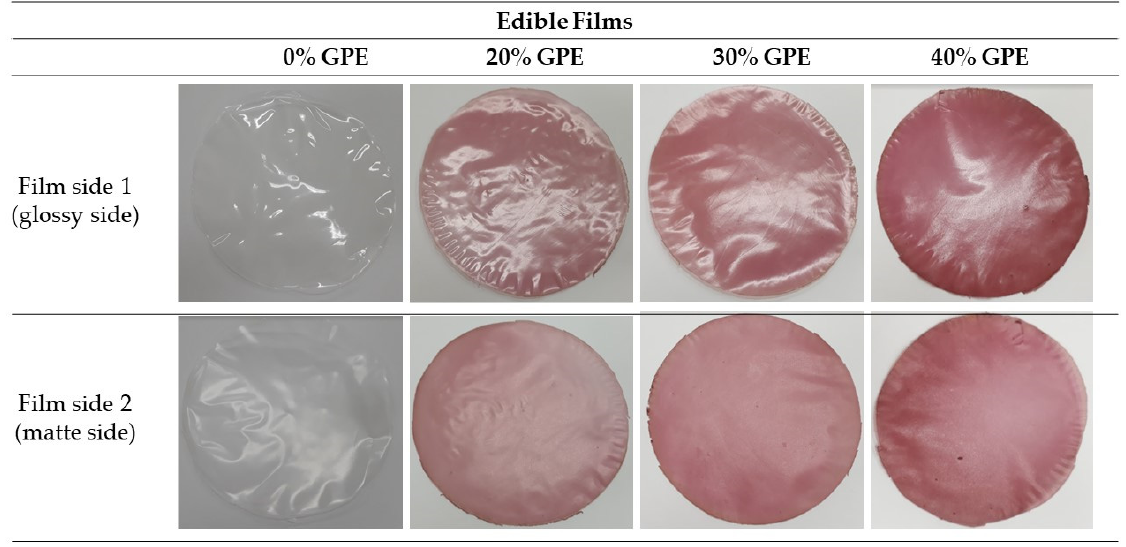
Figure 1. Digital photographs of the edible films of arrowroot ( Maranta arundinacea Linn.) starch with 0, 20, 30, and 40% of grape pomace extract (GPE).